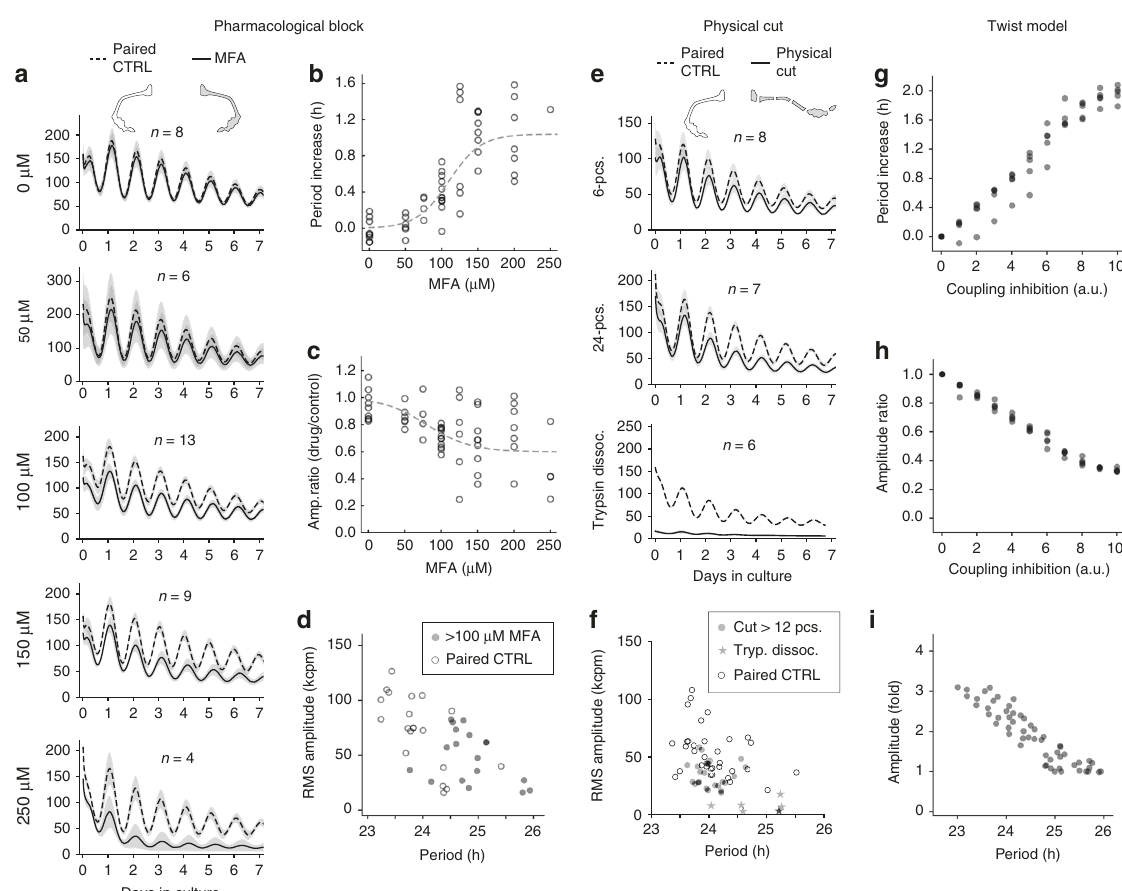
Fig. 3 Gap junctions mediate the inverse relationship between the period and the amplitude, as the twist coupling model demonstrates. a – f The left and right pair of the 4V CP can be used as a control and a test pair to directly compare the effects of pharmacological block of gap junctions or of physical chopping along the length of the CP. a (From top to bottom) Shown are ensemble averages of all PER2::LUC oscillations in kcpm for the control (dashed) and the MFA-treated (solid) groups. Shades indicate the standard error of the mean. The number of samples n per group is indicated in each panel and the same set of data is used in b – d . b The period increases dose-dependently as the MFA concentration increases. Each data point is a difference between periods of the MEA-treated CP and its paired control, and indicates a data from one animal. c The RMS amplitude ratio of the MFA-treated CP to its paired control decreases with increasing concentration of MFA. d Together, an inverse relation between the period and the amplitude can be found, with the high MFA concentration group in the long-period and low-amplitude quadrant. e , f A similar trend can be found in the physically cut samples. Upper panels show the cases when the test pair of the CP is cut into 6 and 24 pieces, and when the test pair was enzyme dissociated with trypsin. g – i The twist coupling model recaptures the acceleration of the circadian oscillation and increase in amplitude by coupling. In the simulation, results from fi ve sets of periods and initial phases randomly generated from a normal distribution (1 h standard deviation) are